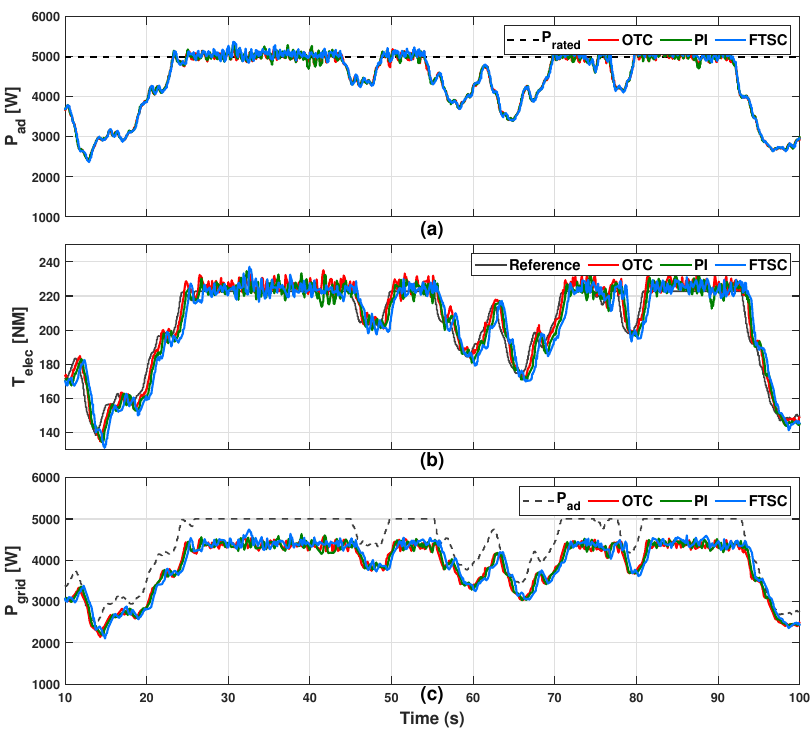
Figure 25. Experimental comparative evaluation of PMVG-based WECS under varying wind profile case-II . ( a ) Aerodynamic power. ( b ) Electromagnetic torque. ( c ) Power transfer to utility grid.